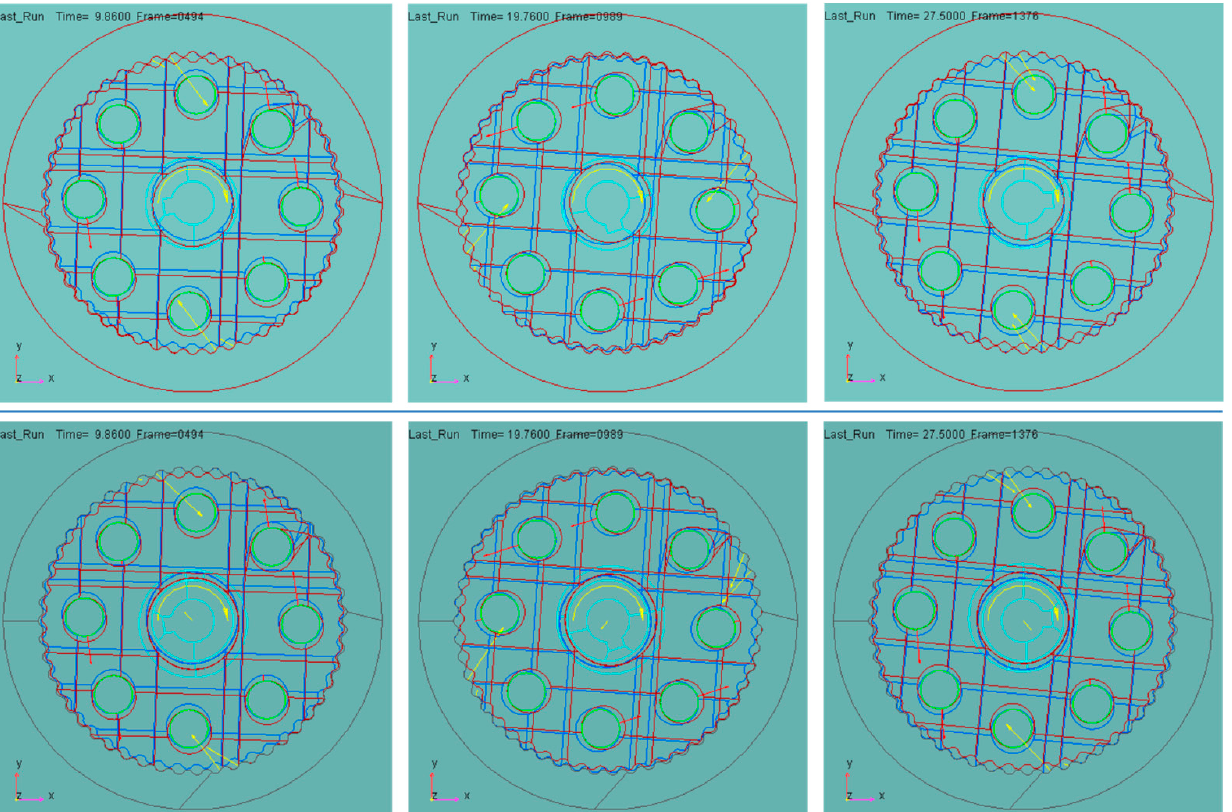
Table 1. Parameters used in the dynamic simulations.